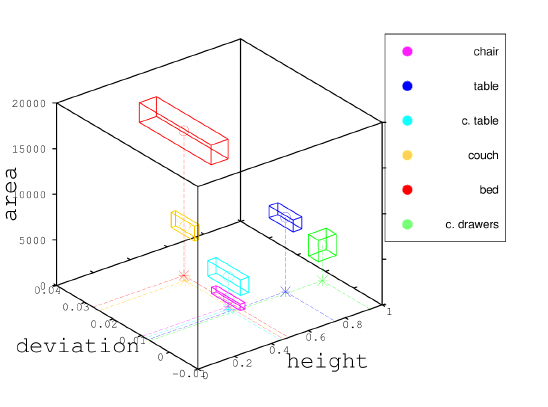
Figure 9. Characteristics of the main geometrical component (horizontal plane) for diverse pieces of